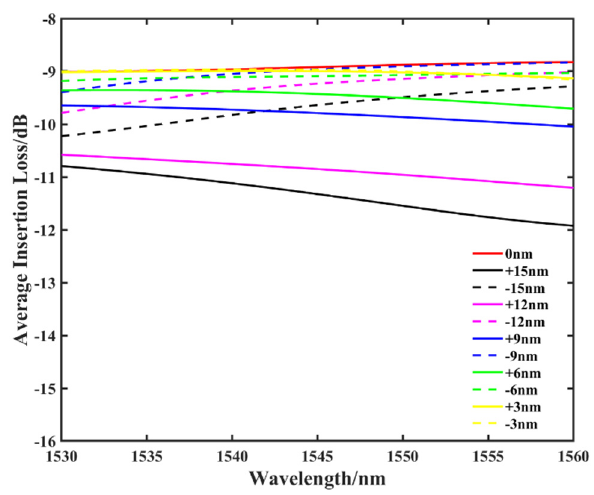
Figure 6. The simulated results under the diameter variations.